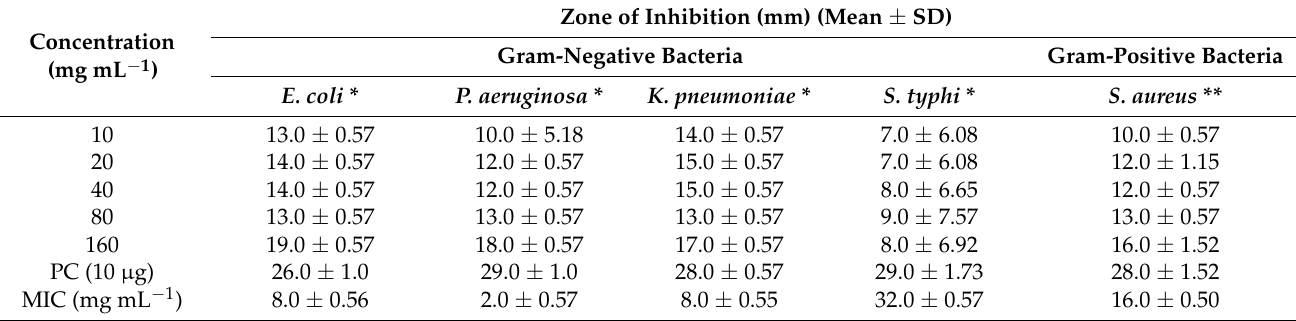
Table 3. In-vitro antibacterial activity and MIC of S. anquetilia methanol leaf extract against tested bacterial